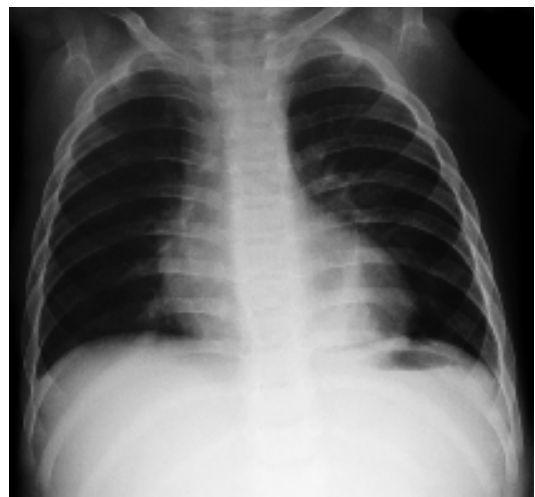
Pulmonary sequestration. Chest radiograph of an 8-month- old boy with intrapulmonary sequestration in the posterior basal segment of the left lower lobe. The triangular lesion was found incidentally, and the boy was